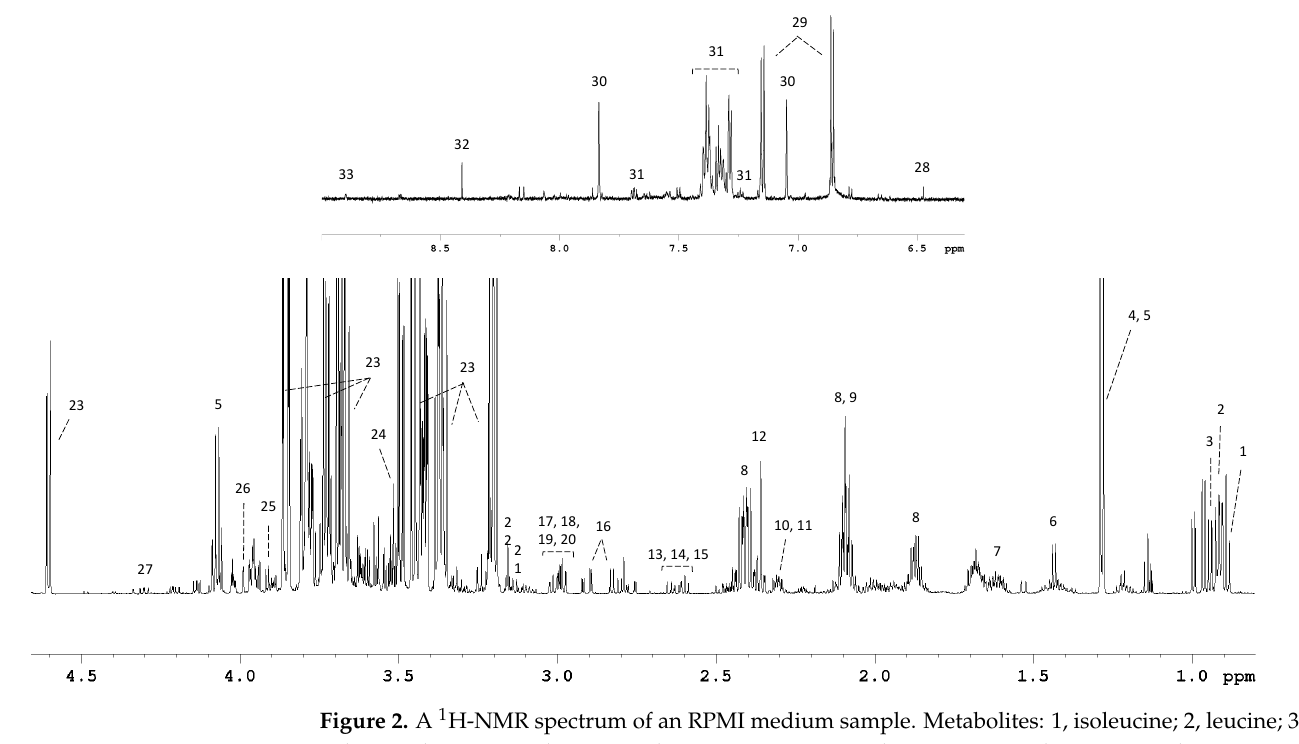
Figure 2. A 1 H-NMR spectrum of an RPMI medium sample. Metabolites: 1, isoleucine; 2, leucine; 3, valine; 4, threonine; 5, lactate; 6, alanine; 7, arginine; 8, glutamine; 9, methionine; 10, glutamate; 11, proline; 12, succinate; 13, methionine; 14, citrate; 15, aspartate; 16, asparagine; 17, lysine; 18, creatine; 19, creatinine; 20, ornithine; 21, cystine; 22, choline; 23, glucose; 24, glycine; 25, serine; 26, fructose; 27, trans-4-Hydroxy-L-proline; 28, fumarate; 29, tyrosine; 30, histidine; 31 tryptophan; 31, phenylalanine; 32, formate; 33,